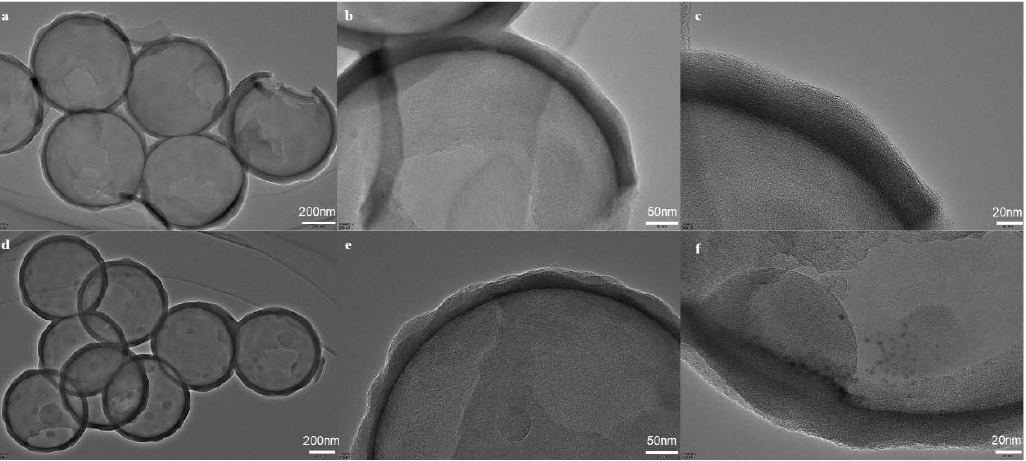
Figure 3. TEM images of MHS ( a – c ) and MMHS ( d – f ).